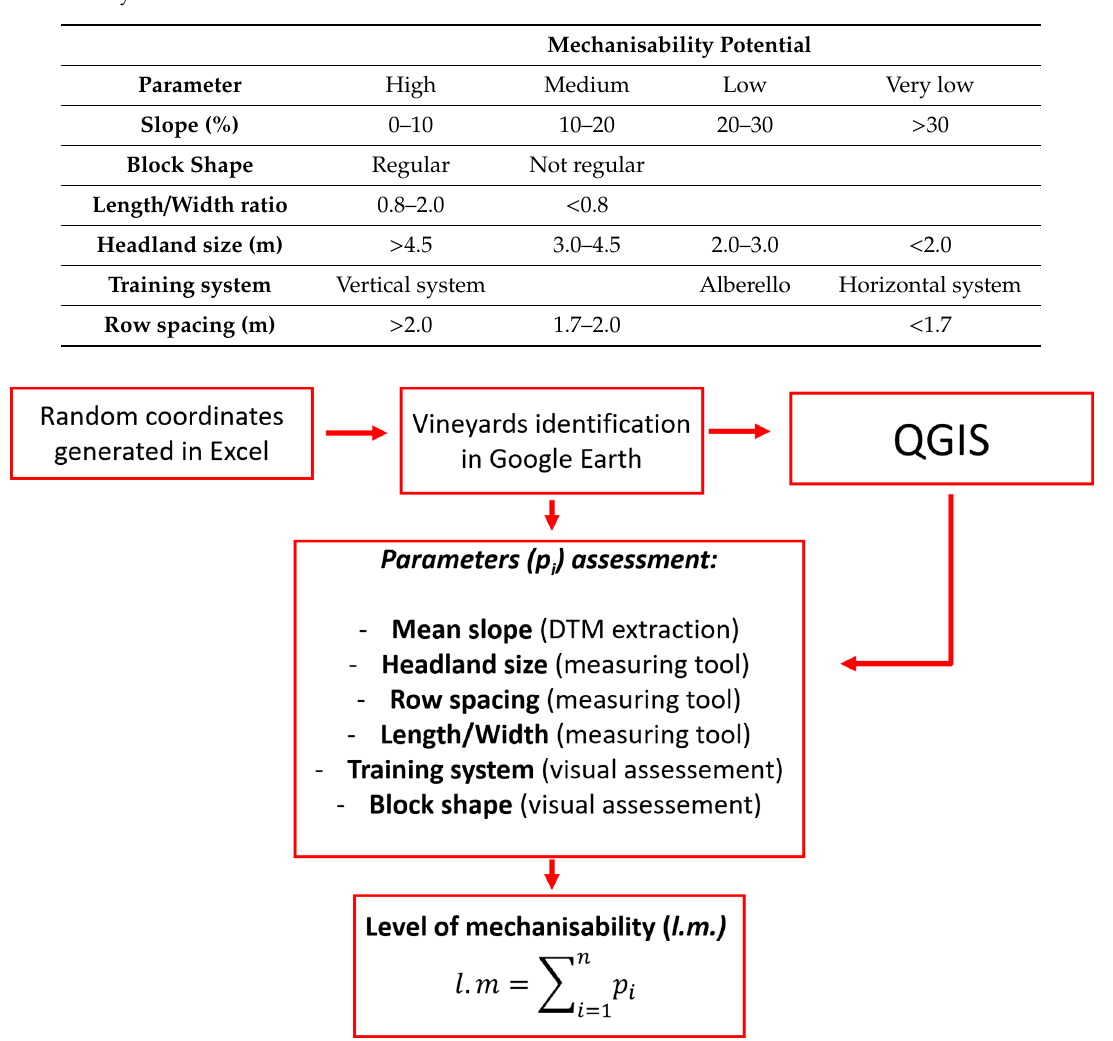
Table 6. Synopsis of the contribution of the single parameters on the mechanisability potential of vineyards.